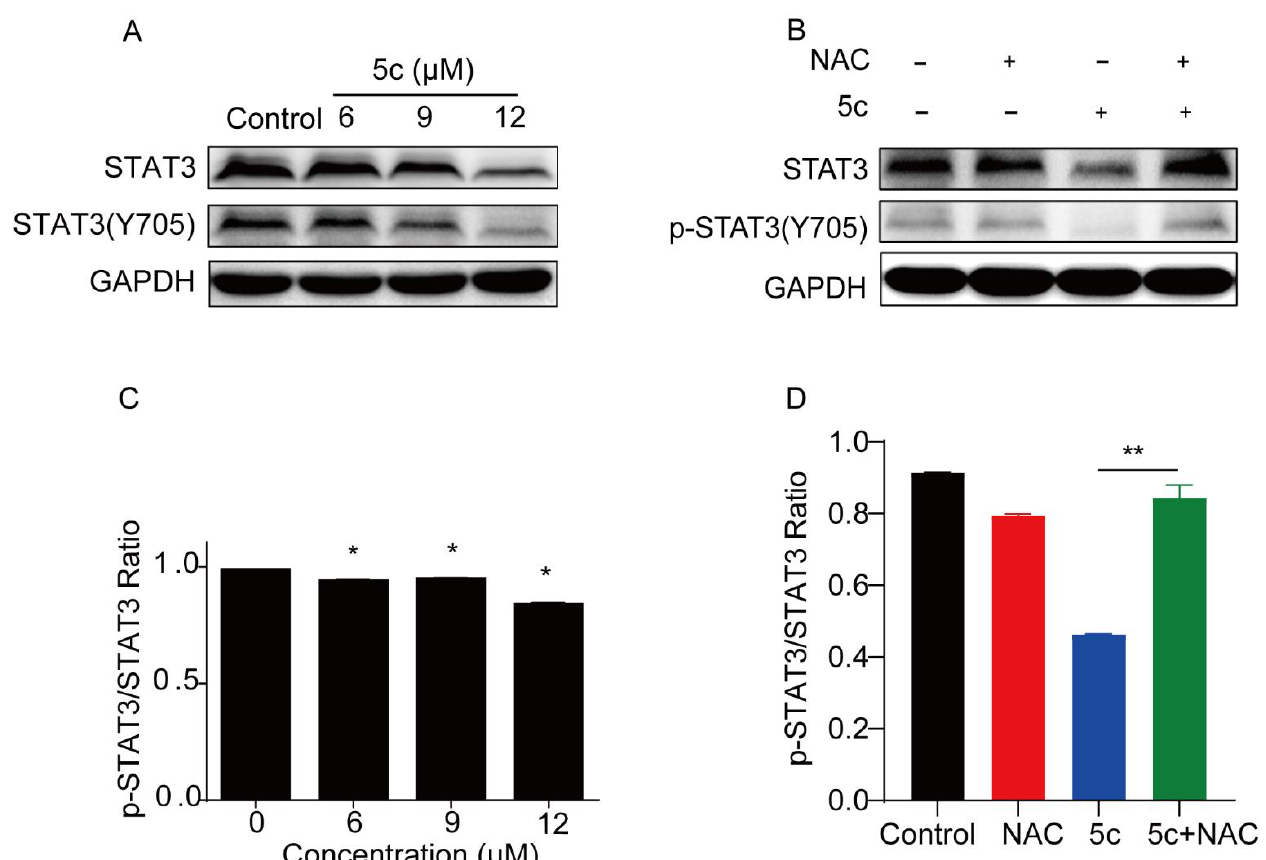
Figure 9. The compound 5c -reduced STAT3 tyrosine phosphorylation in HeLa cells. ( A ) Concentration-dependent inhibition of STAT3 tyrosine phosphorylation in HeLa cells by compound 5c for the 24 h interval. ( B ) HeLa cells were pretreated with NAC (5 mM, 1 h) before incubation with compound 5c for a 24 h interval; Western blot experiments showed that 5c inhibited STAT3 (Y705) phosphorylation, and NAC weakened this effect. ( C ) Quantitative statistics of the results in A using ImageJ 1.8.0 software. ( D ) Quantitative statistics of the results in B using ImageJ 1.8.0 software. Values